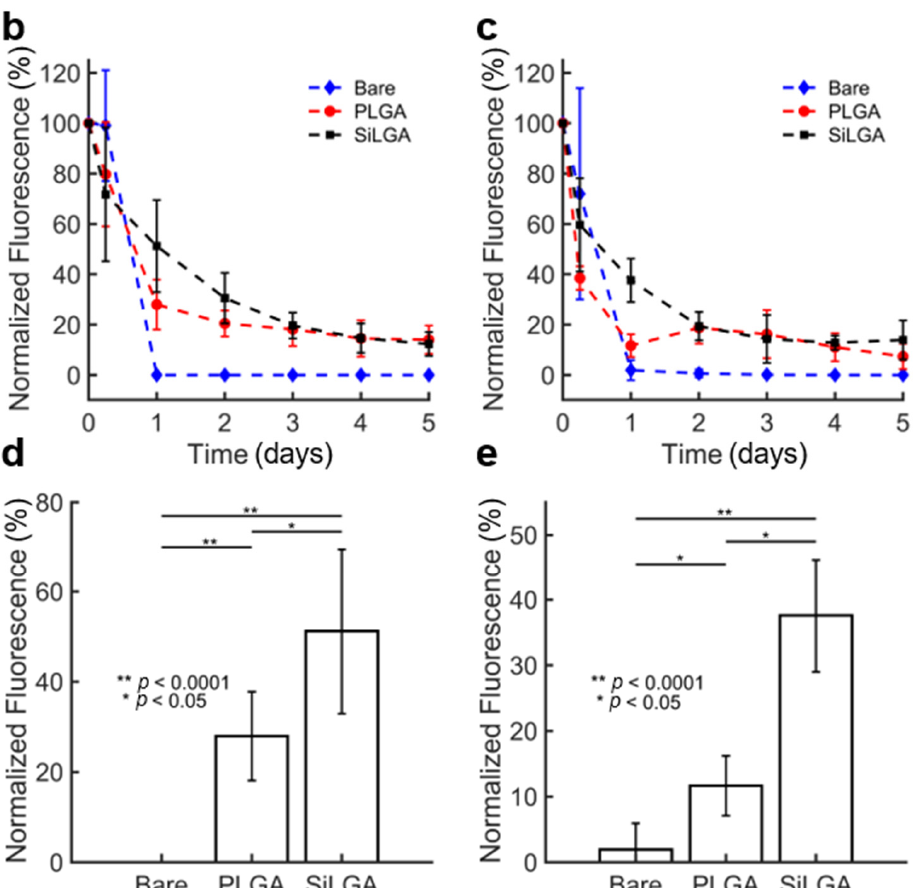
Figure 4. Silica slows burst release kinetics of BSA after intramuscular injection in mice: ( a ) Radiation efficiency of BSA-Cy7 PLGA NPs ( top ), BSA-Cy7 SiLGA NPs ( middle ), and unencapsulated BSA-Cy7 ( bottom ) in the hind legs of immunocompetent mice (B6a) as imaged over a five-day span; saline was injected into the negative control shown at Day 0. Normalized fluorescence levels of intramuscular BSA-Cy7 over a five-day span in ( b ) B6a and ( c ) NSG mice. Error bars represent one standard deviation above and below the mean normalized fluorescence level, calculated across six injection sites. ( d ) Normalized fluorescence levels of unencapsulated (“Bare”) PLGA, and SiLGA formulations of BSA-Cy7 after one day in ( d ) B6a and ( e ) NSG mice.